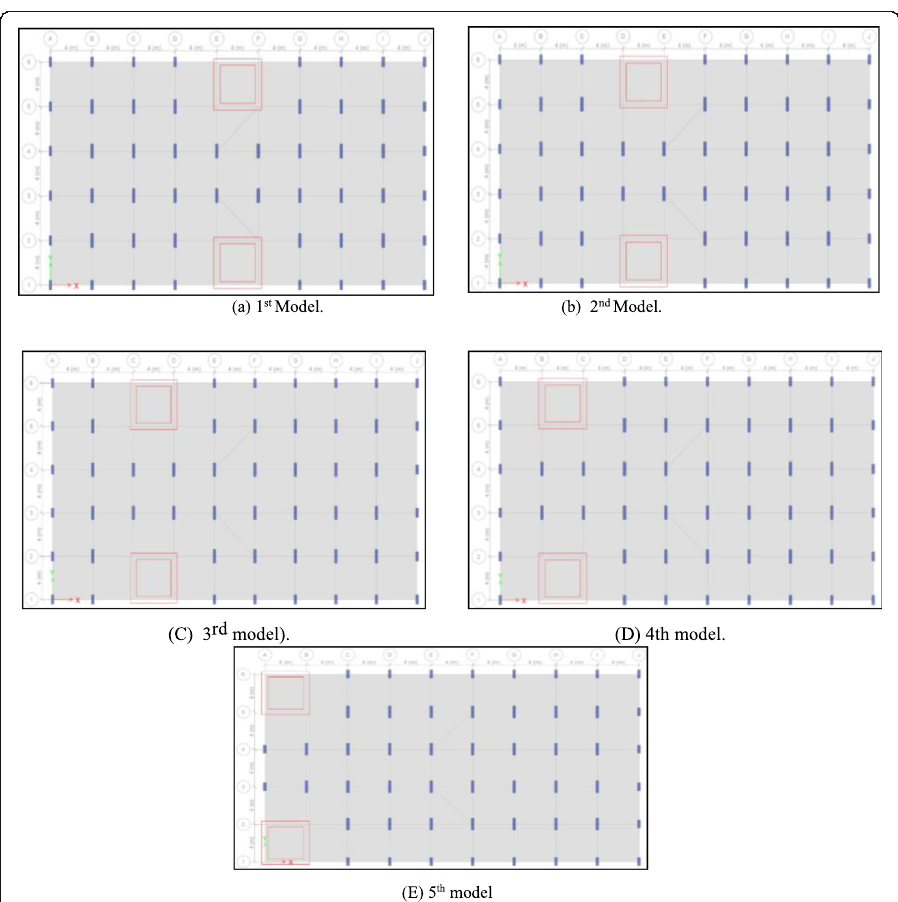
(cid:4) Rotation-based equation gives torsional irregularity coefficients ( A